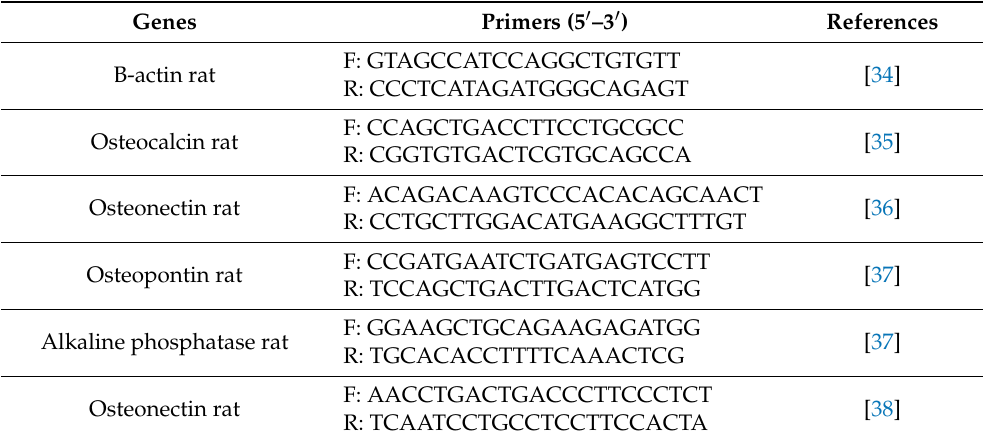
Table 1. Forward (F) and reverse (R) primers of genes used for RT-PCR experiments. Genes Primers (5 (cid:48) –3 (cid:48)